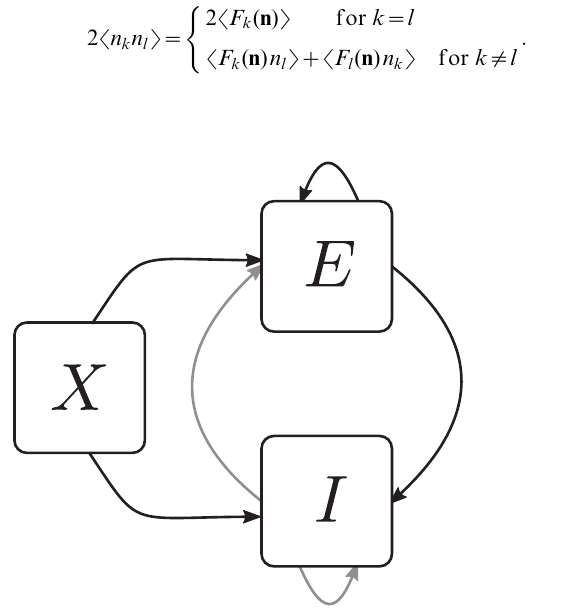
Figure 1. State transitions of a binary neuron. Each neuron is updated at random time points, intervals are i.i.d. exponential with mean duration t , so the rate of updates per neuron i is t { 1 . The probability of neuron i to end in the up-state ( 1 ) is determined by the gain function F i ( n ) which potentially depends on the states n of all neurons in the network. The up-transitions are indicated by black arrows. The probability for the down state ( 0 ) is given by the complementary probability 1 { F i ( n ) , indicated by gray arrows.